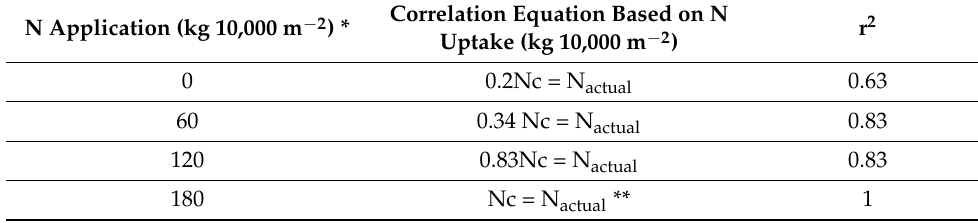
Table 4. Correlations between N actual and Nc in the greenhouse experiments. The slope of the best-fitting linear line is the ratio between actual and potential uptake of N which, by definition, is NNI.